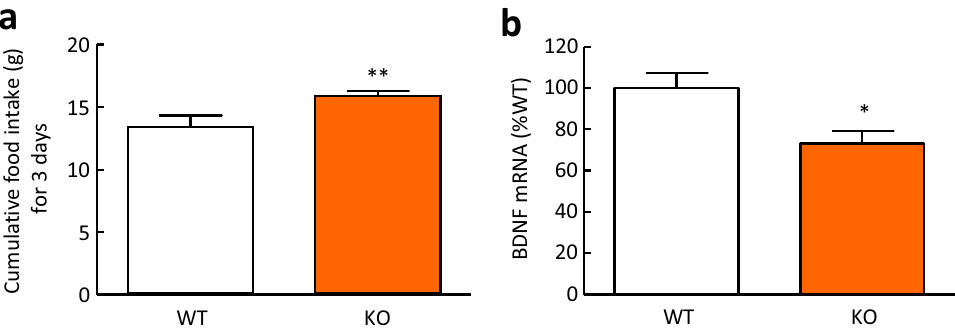
Figure 4. Cumulative food intake and BDNF mRNA expression in the hypothalamus of CX3CR1-deficient mice. ( a ) Cumulative food intake for 3 days. ( b ) BDNF mRNA expression in the hypothalamus. WT: wild-type mice, KO: CX3CR1-deficiet mice. Results are expressed as mean ± SEM for 7–8 mice. Significant differences: * p < 0.05, ** p <